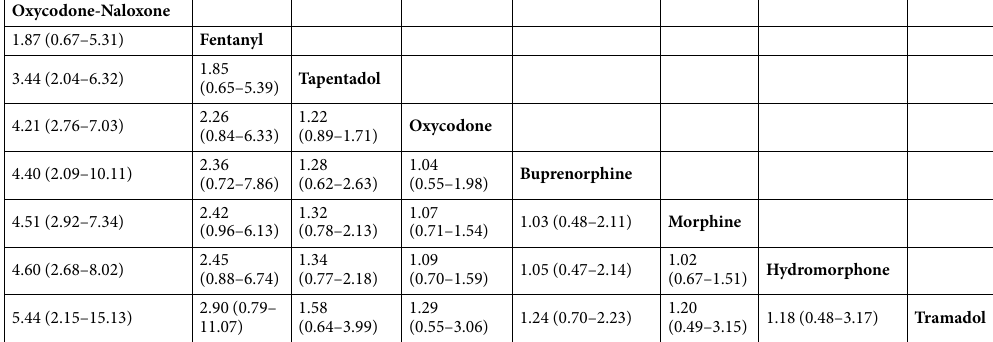
Table 5. League table showing the odds ratios (OR) of various opioids in achieving PATIENT SATISFACTION in pain relief. OR > 1 means the treatment in top left is